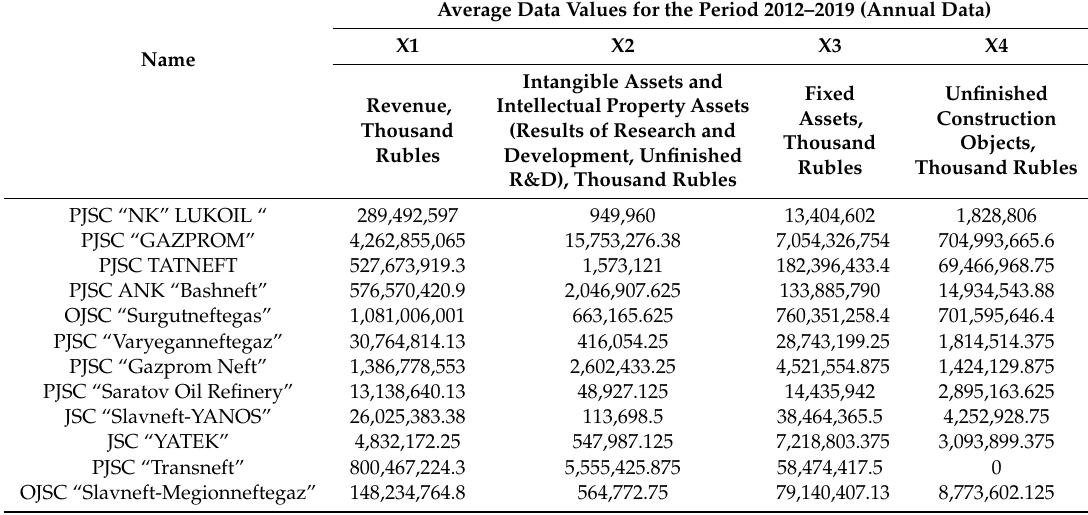
Table A1. Research results for the oil and gas industry (annual data, yearly